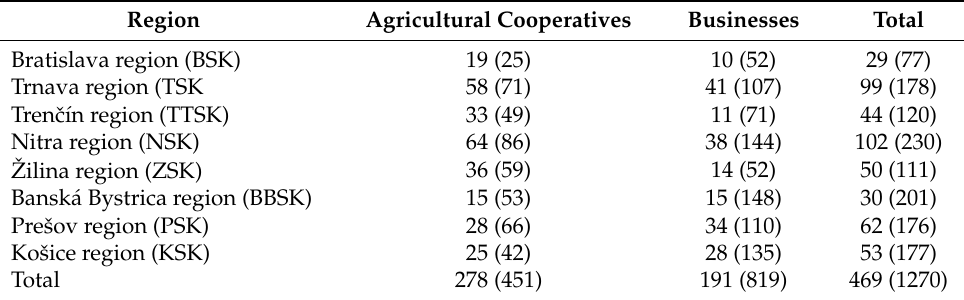
Table 2. Structure of the research sample by legal form and region. Region Agricultural